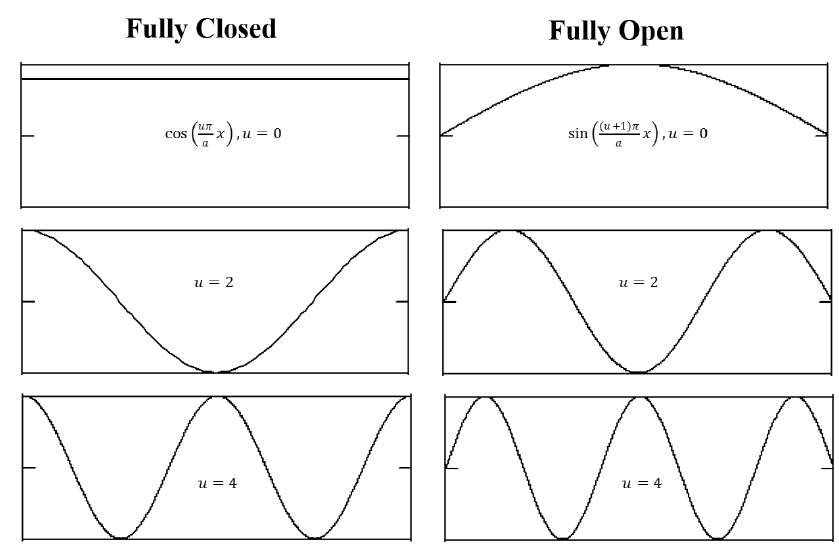
Figure 4. Acoustic mode shapes of the fully open and fully closed cavity boundaries.